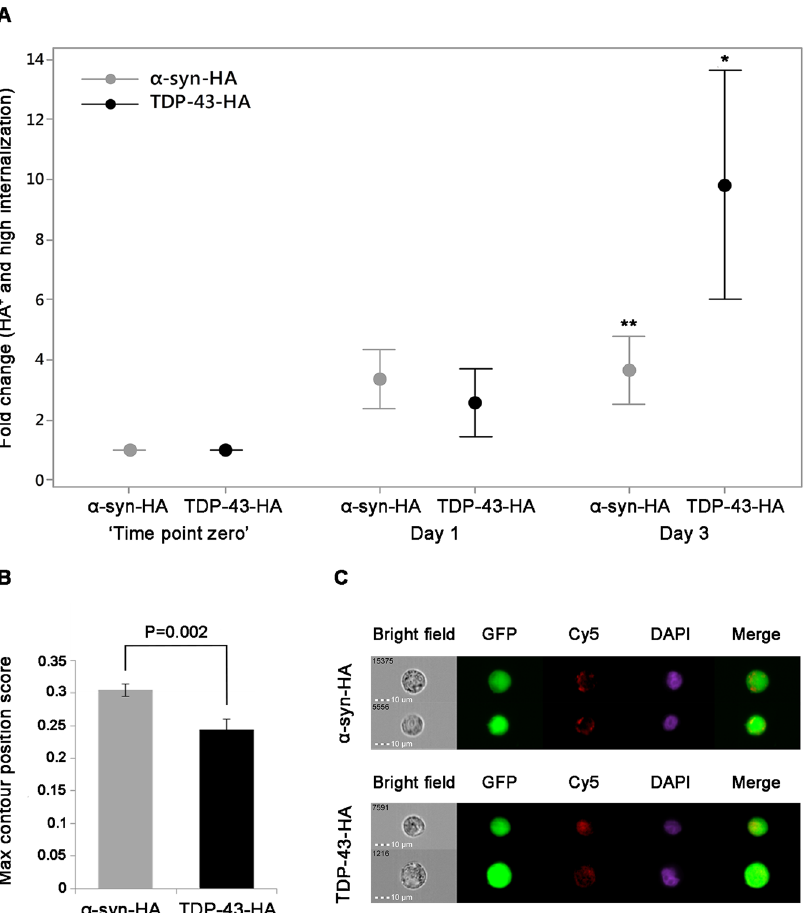
Figure 4. Quantification of transmission events and localization analysis of the HA-tagged α -synuclein and TDP-43 in GFP-expressing ‘recipient’ cells. ( A ) Quantification of transmission events over time presented as fold change ratio compared to the corresponding ‘time point zero’ (P = * 0.03 ** 0.005 each compared to ‘time point zero’). ( B ) Mean value of the intracellular localization score calculated using the Max Contour Position score (see Materials and Methods for details). ( C ) Representative images of HA-tagged α -synuclein and TDP- 43. DAPI staining pinpoints to the nucleus and facilitates identifying the localization of the Cy5 staining. In each series of experiments n = 8 biological repeats, each comprising 100,000